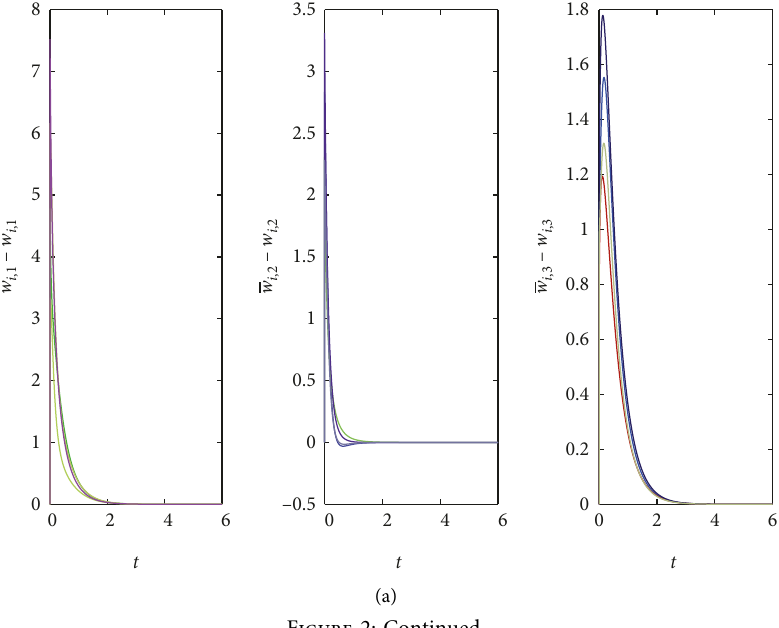
l x t ij j . (b) Convergence of i � 10